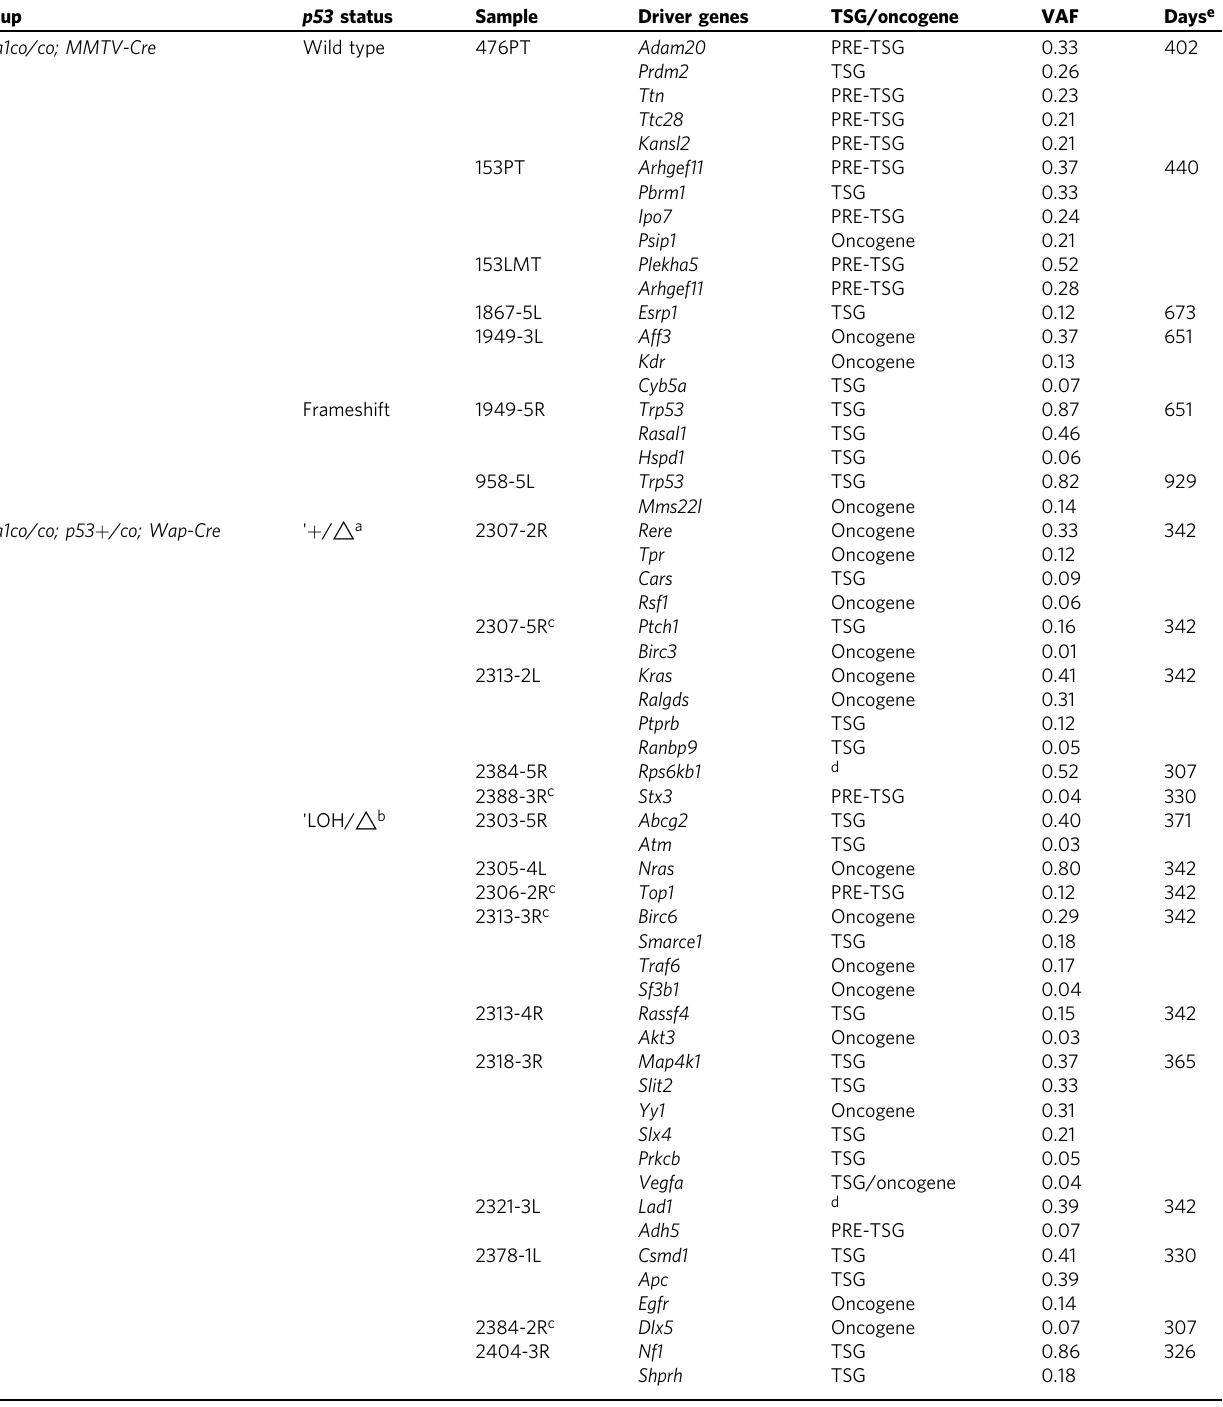
Table 1 Potential driver genes in each